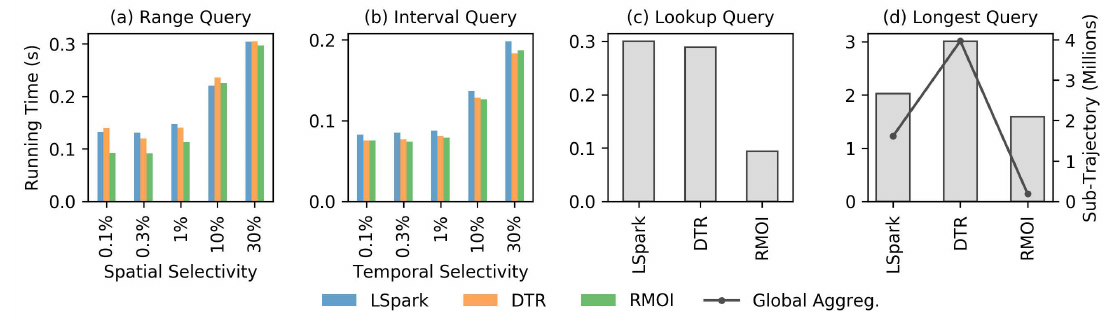
Figure 3. Average execution time for the SF dataset with high resource availability on ( a ) range query, ( b ) interval query, ( c ) lookup query, and ( d ) longest